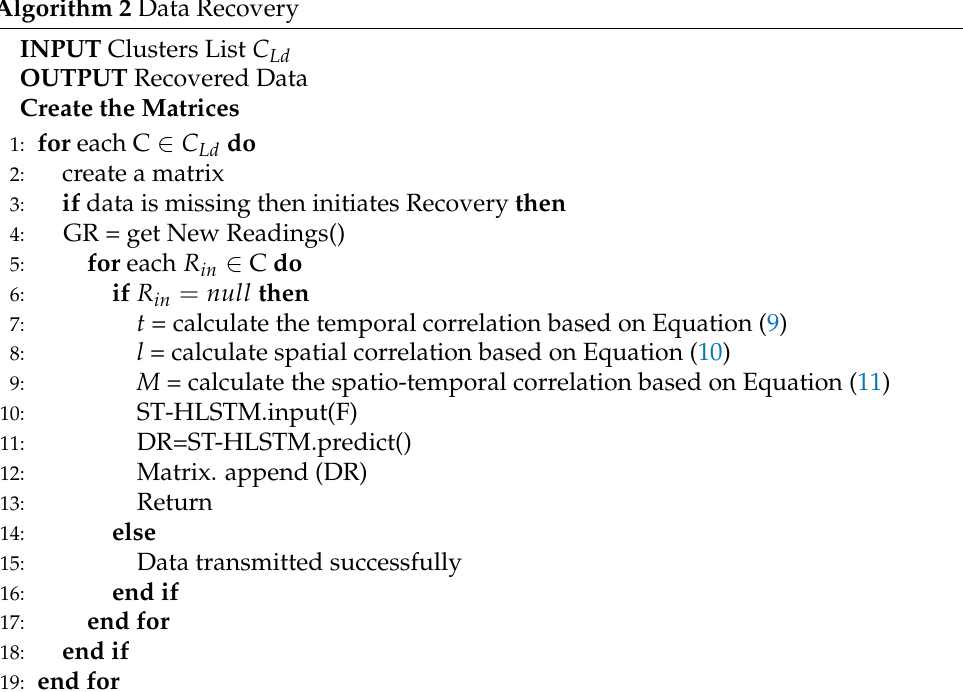
Algorithm 2 Data